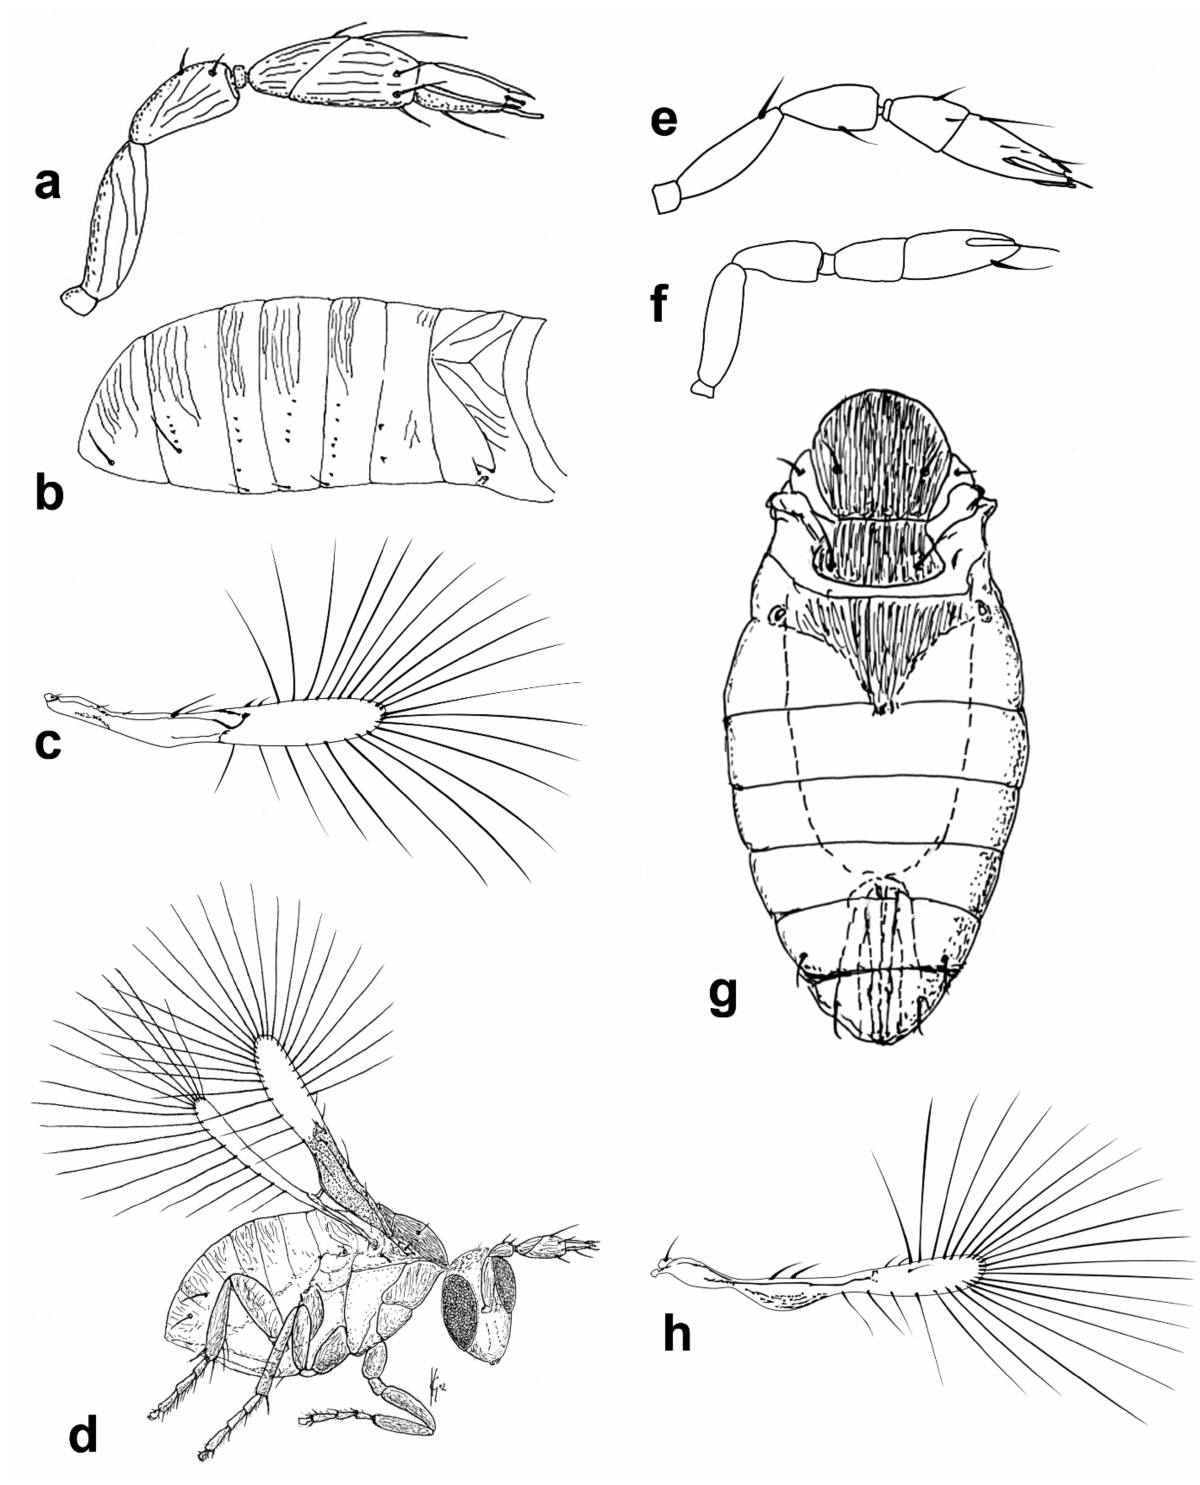
Figure 9. Line drawings of Megaphragma species: ( a ) M. rivelloi , female antenna (Holotype); ( b ) M. rivelloi , female metasoma (Holotype); ( c ) M. rivelloi , female fore wing (Holotype); ( d ) M. rivelloi , female habitus (Holotype); ( e ) M. stenopterum , female antenna (Paratype); ( f ) M. stenopterum , male antenna (Paratype); ( g ) M. stenopterum , female dorsal meso- and metasoma (Paratype); ( h ) M. stenopterum , female fore wing